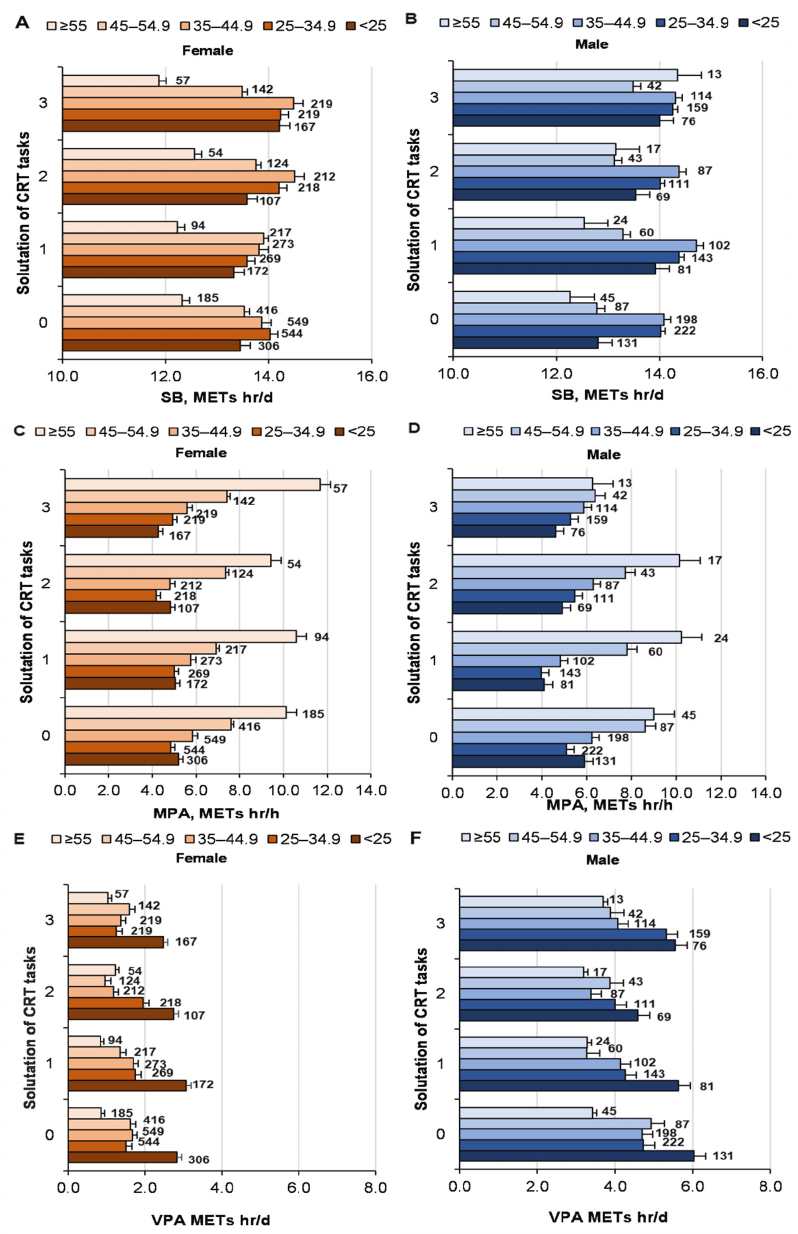
Figure 3. Solving CRT problems by men and women in different age groups with PA (SB, MPA, VPA, MVPA). At the top of the column is the number of participants. (( A )—women solutions of CRT and SB; ( B )—men solutions of CRT and SB; ( C )—women solutions of CRT and MPA; ( D )—men solutions of CRT and MPA; ( E )—women solutions of CRT and VPA; ( F )—men solutions of CRT and VPA).